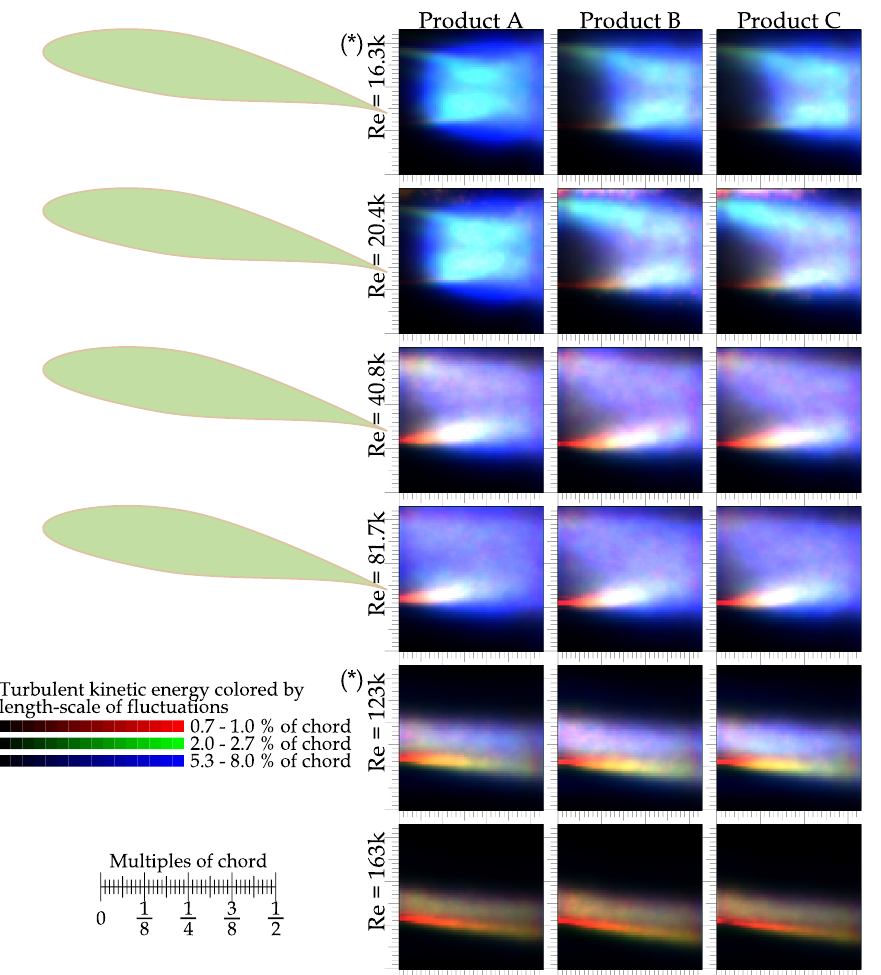
Figure A4. Turbulent kinetic energy colored by the length-scale of fluctuations producing it. TKE is divided into three channels: the red channel represents the smallest length-scale of fluctuations, the green channel shows fluctuations of middle sizes, and the blue represents the largest fluctuations. The color scale for different color channels is normalized in such a way that an ideal Kolmogorov turbulence would be displayed in shades of gray. Among different Re and variants, the color scale is automatically adapted (for differences in amounts of TKE, look to Figure A3. Rows denoted by (*) are